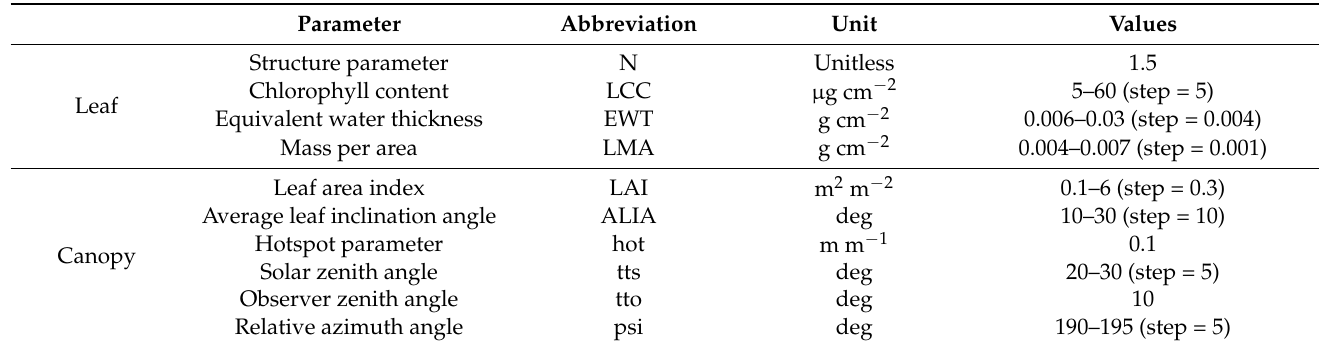
Table 2. Ranges of input parameters for the PROSAIL model for generating the